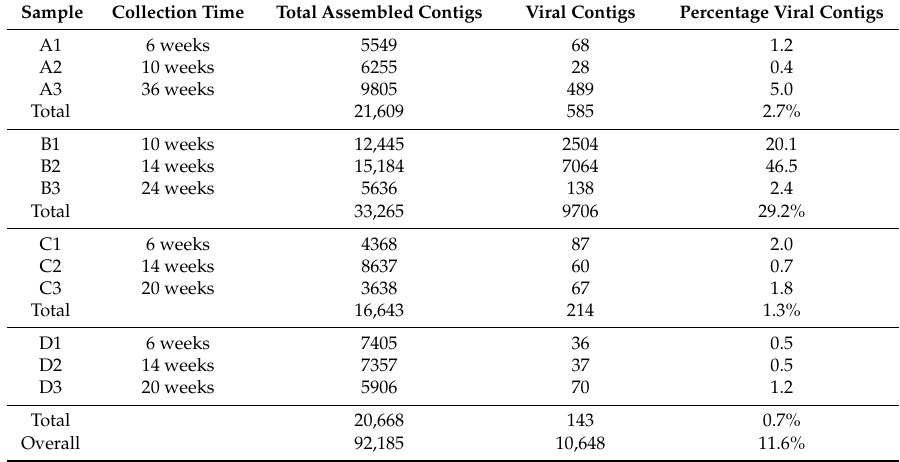
Table 1. Summary of the distribution of assembled contigs obtained from the twelve faecal samples of the four study